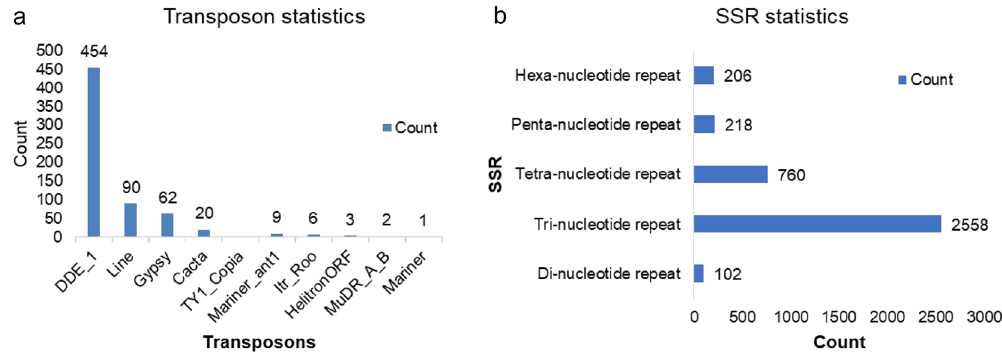
Figure 3. Abundance and distribution of the repeated elements in S. sclerotiorum ‘ ESR-01’ isolate. ( a ) transposable elements ( b ) SSR